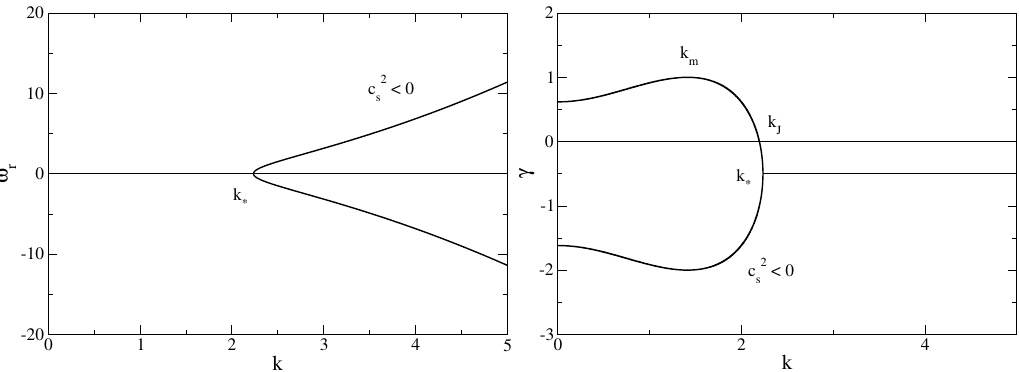
Figure 15. Dispersion relation for self-gravitating BECs in the general case when c 2 s < 0. We have normalized the wavenumber by ( 4 π G ρ m 2 /¯ h 2 ) 1/4 , the pulsation and the friction by ( 4 π G ρ ) 1/2 , and the squared speed of sound by ( 4 π G ρ ¯ h 2 / m 2 ) 1/2 . This is equivalent to taking 4 π G = ρ = m = ¯ h = 1 in the dimensional equations. We have selected c 2 s = − 1 and ξ =